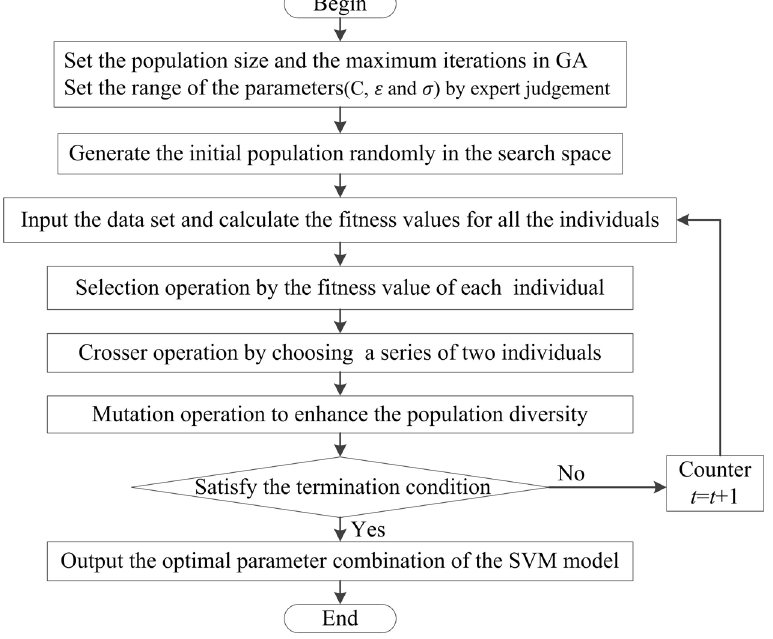
Figure 4. The flow chart of optimizing SVM using